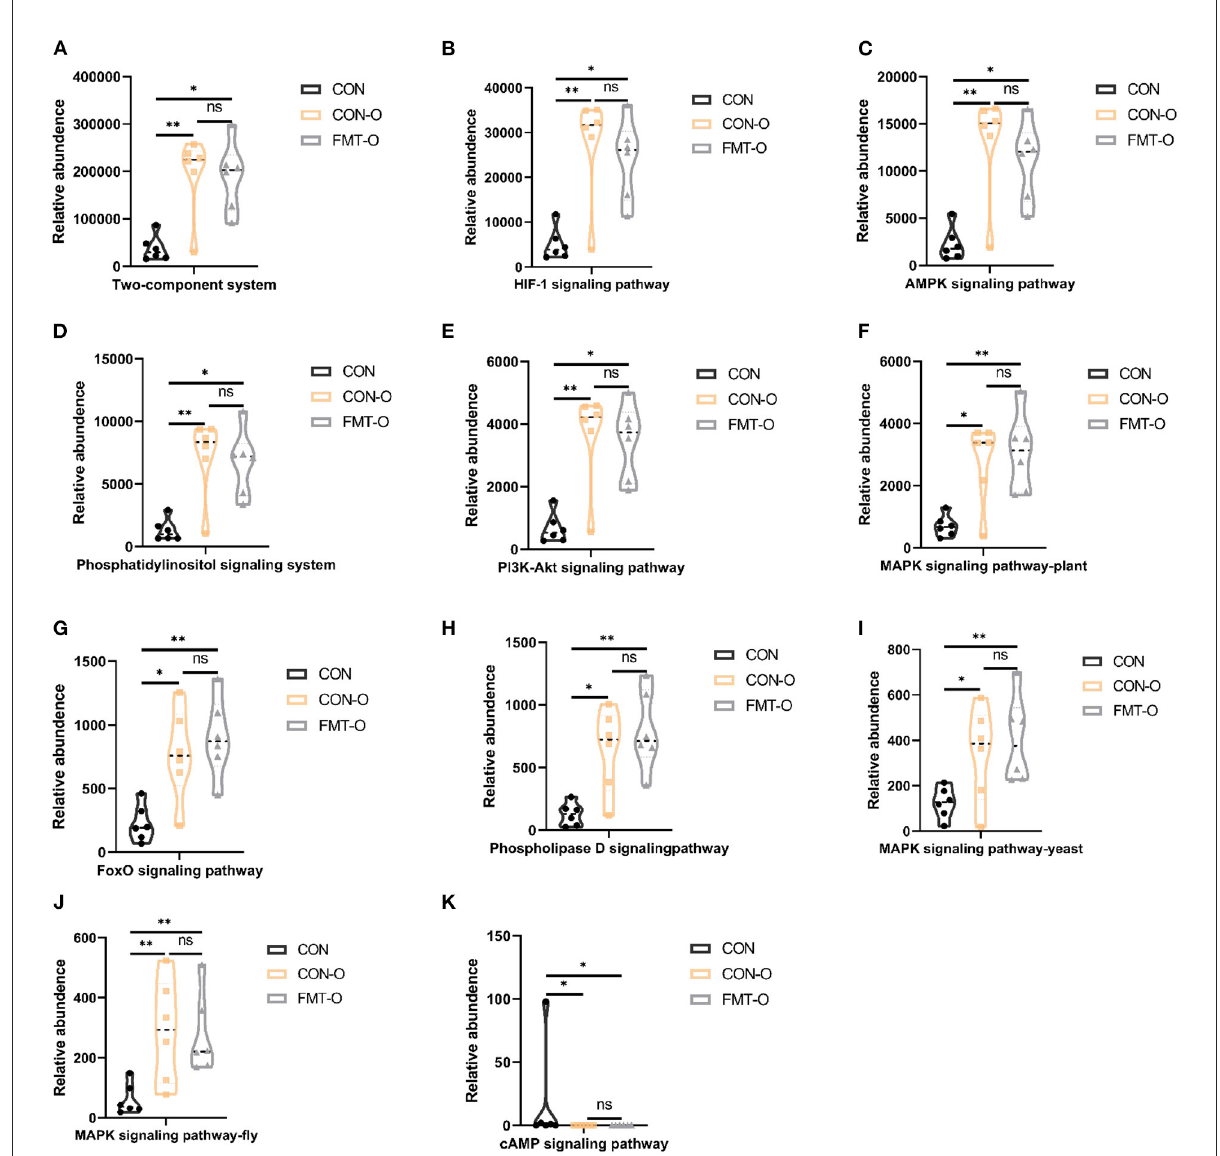
FIGURE10 Signal transduction pathways enriched by the significantly different genera in older mice which were screened by fecal microbiota transplantation ( n = 6). The relative abundance of Two-component system, HIF-1 signaling pathway, AMPK signaling pathway, Phosphatidylinositol signaling system, PI3K-Akt signaling pathway, MAPK signaling pathway-plant, FoxO signaling pathway, Phospholipase D signaling pathway, MAPK signaling pathway-fly, MAPK signaling pathway-yeast and cAMP signaling pathway (A–K) . * p < 0.05, ** p < 0.01; ns, no